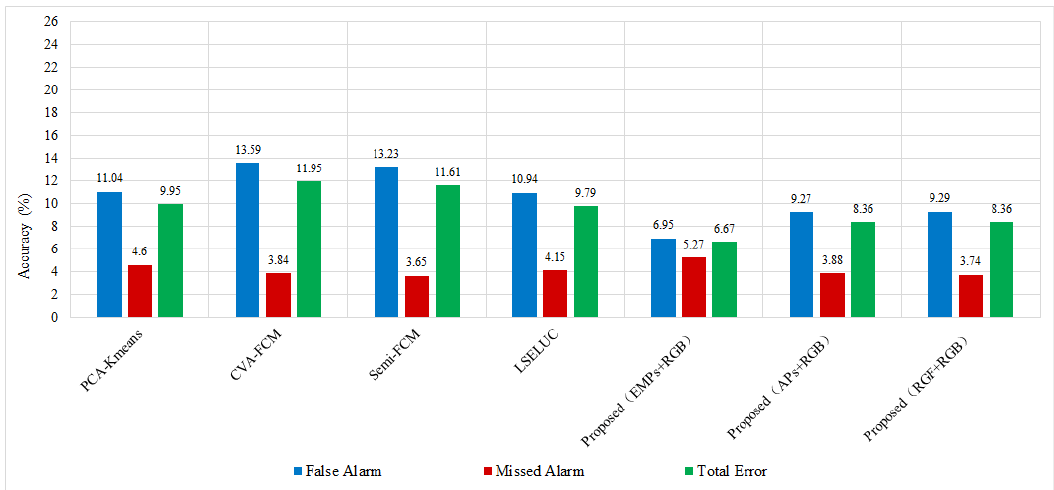
Figure 7. A comparison of the bar charts for the Site B landslide detection VHR remote sensing images.